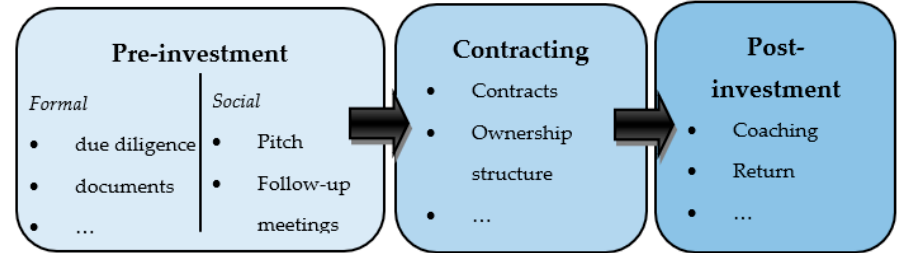
Figure 1. Steps of trust building during the entrepreneur–investor relationship.